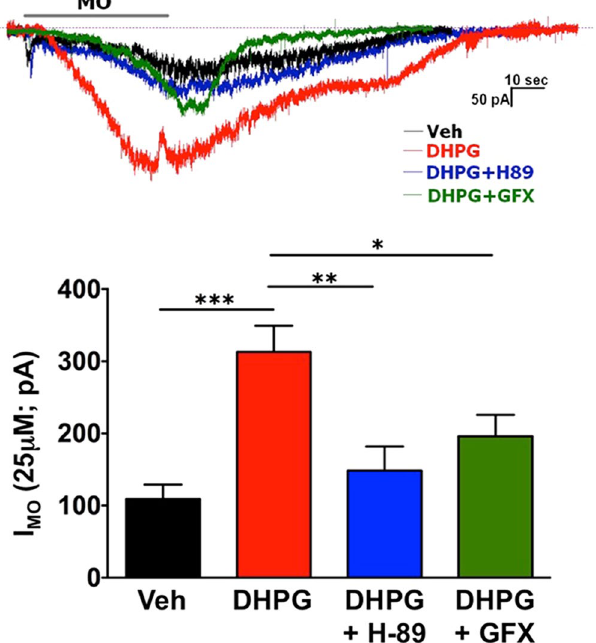
Figure 7. mGluR5-sensitization of TRPA1 Current is Sensitive to PKA and PKC Inhibition. Mustard oil (MO; 25 μ M)-activated current was recorded from DRG sensory neurons. MO was applied for 30 sec. Vehicle (ddH2O), DHPG, H89 (PKA inhibitor) and GFX (PKC inhibitor) were applied at concentrations of 10 μ M (each). DRG neurons were incubated for 10 min with drugs marked on X-axis, followed by co-application of MO. * p < 0.05; ** p < 0.01; *** p < 0.001; n = 7–10 MO responsive cells; one-way ANOVA with Bonferroni’s post-hoc